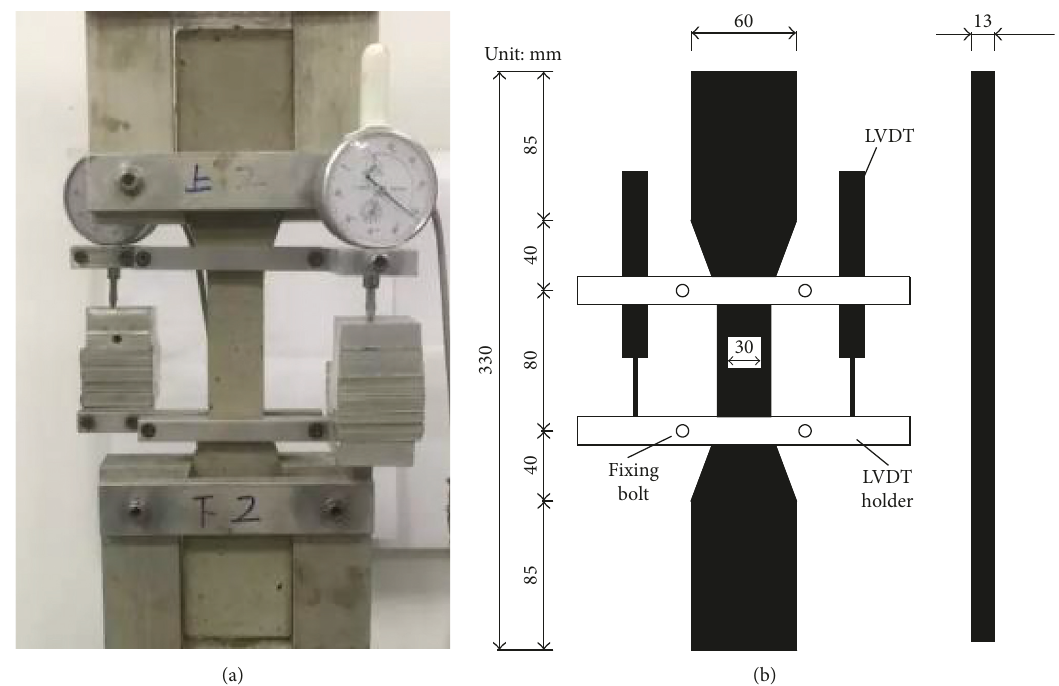
Figure 4: The uniaxial tensile test: (a) test setup and (b) specimen dimensions.